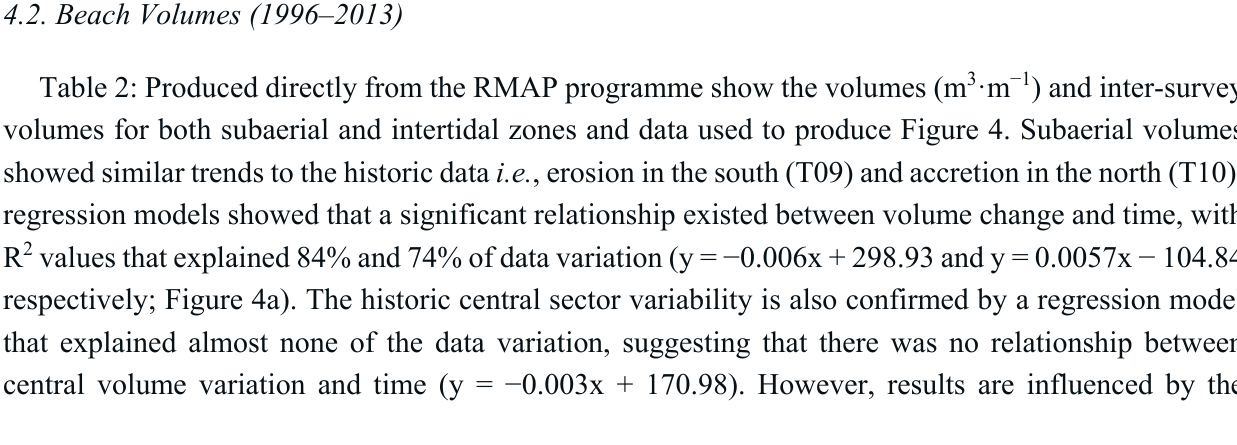
Table 2: Produced directly from the RMAP programme show the volumes (m 3 ·m − 1 ) and inter-survey volumes for both subaerial and intertidal zones and data used to produce Figure 4. Subaerial volumes showed similar trends to the historic data i.e. , erosion in the south (T09) and accretion in the north